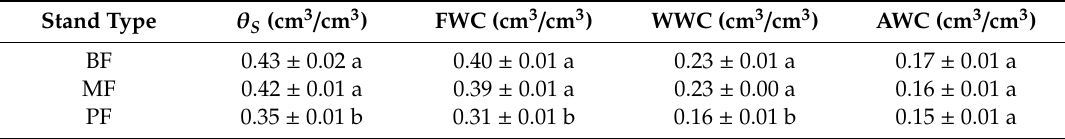
Table 3. E ff ect of various forests on soil water retention characteristics across the 0–100 depth. Stand Type